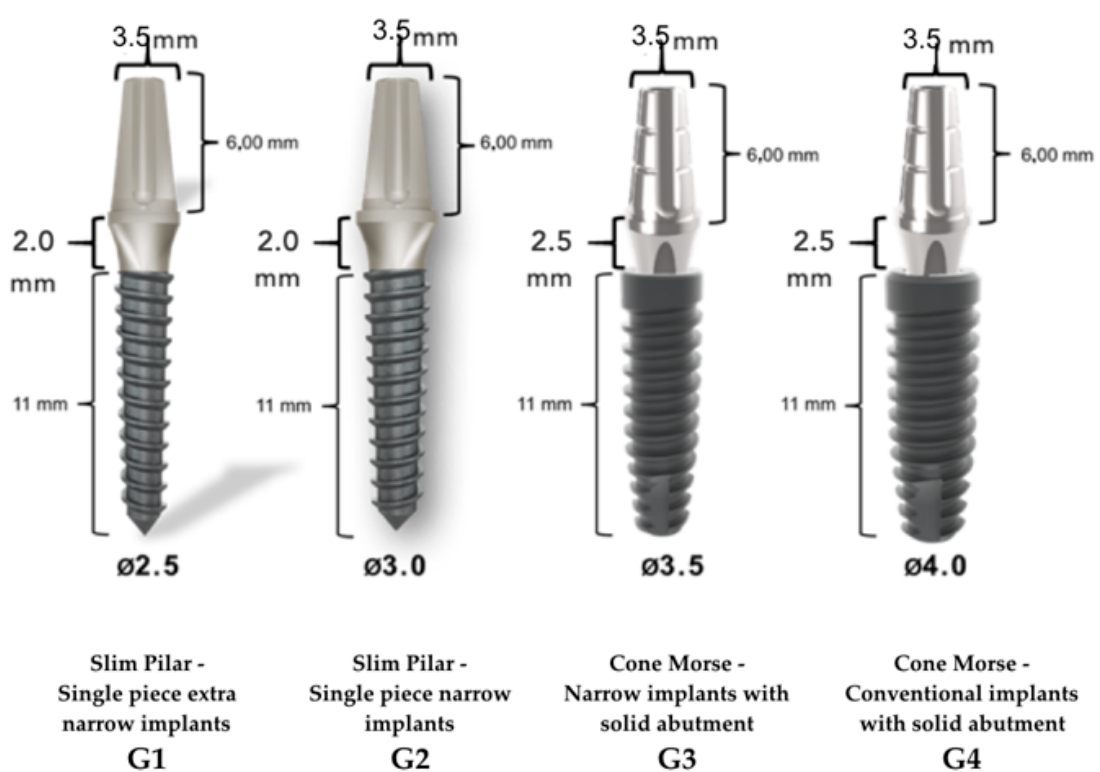
Figure 2. Implacil de Bortoli cone Morse implants, with 6 mm height solid abutment.